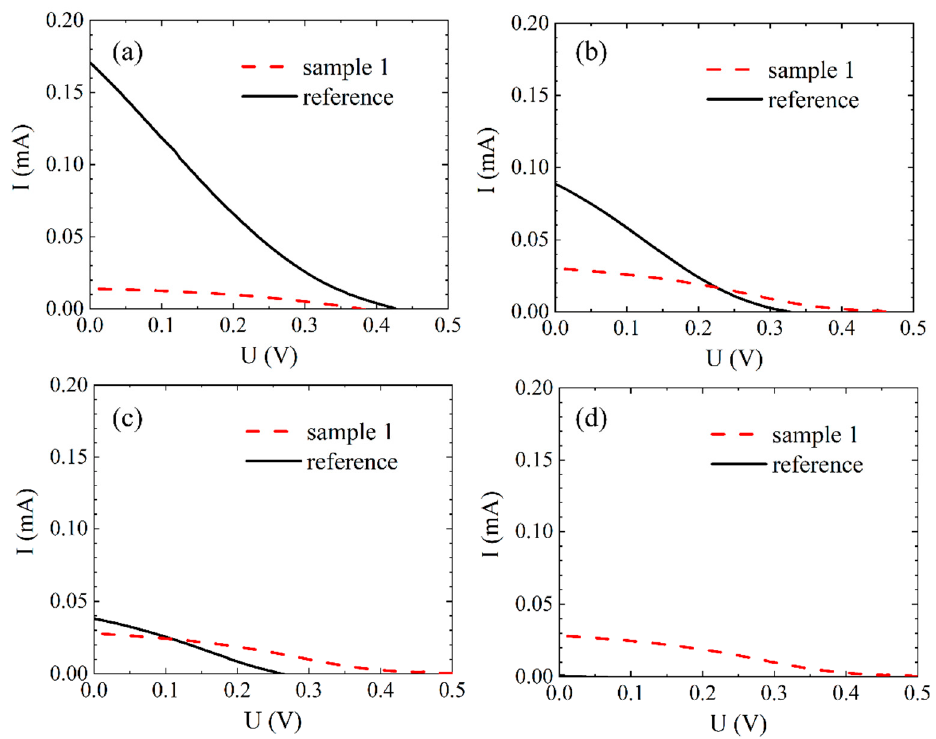
Figure 7. Measured I-U curves of sample 1 and the reference: ( a ) on day 0; ( b ) day 15; ( c ) day 31; ( d ) day 52.